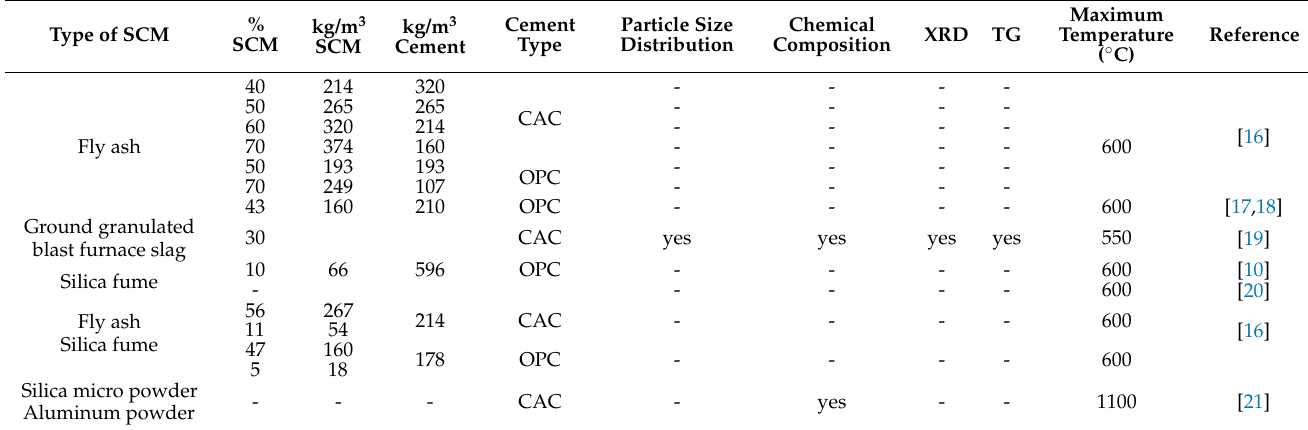
Table 1. SCM used in concrete for TES in CSP plant